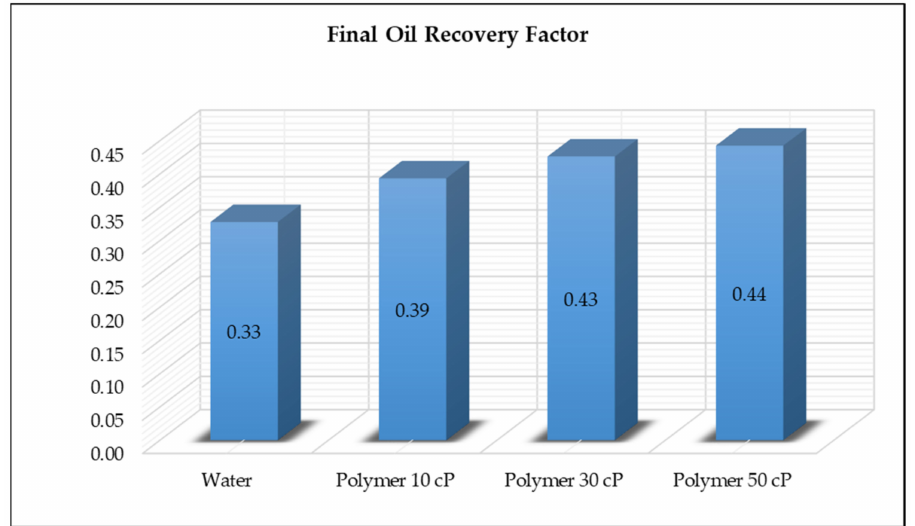
Figure 9. Final oil recovery factor for various oil displacement options.